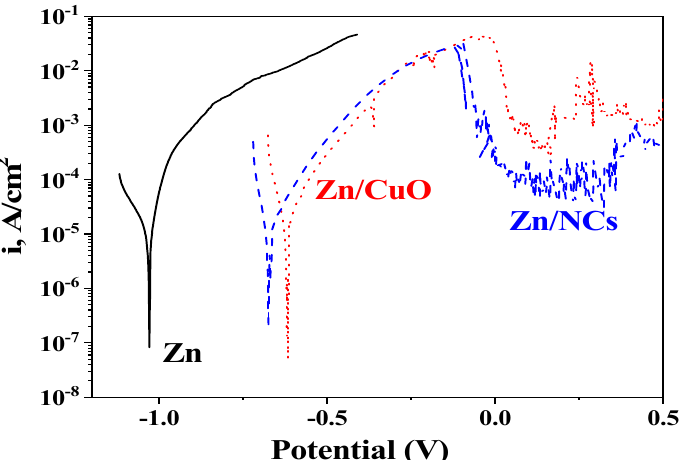
Figure 8. Potentiodynamic polarization measurements after a 55-day immersion in 5% NaCl solution. It is also visible that the corrosive-treated hybrid samples dissolve completely for a longer period of time, which is a sign of a slower rate of anodic dissolution under these